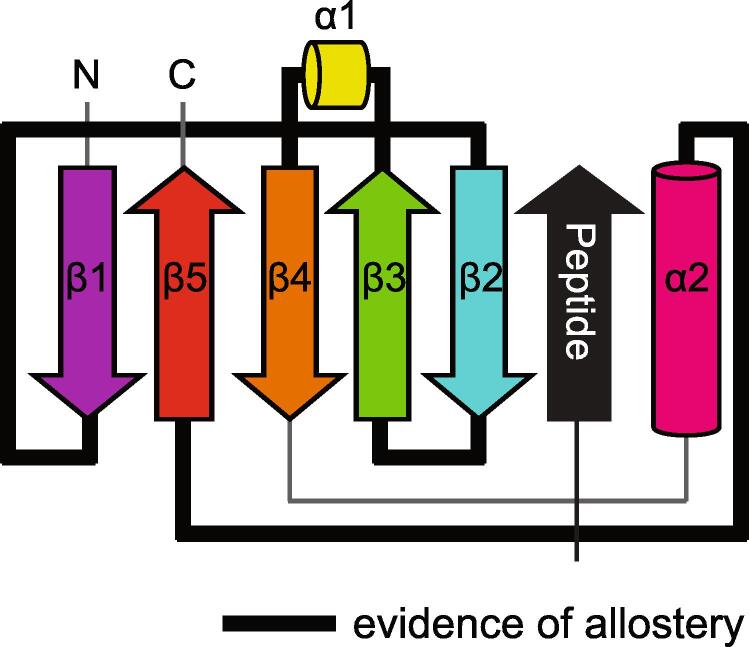
Reported regions of allostery in a PDZ domain. A two-dimensional schematic of the common PDZ domain fold is shown. The loops that have shown evidence of allostery are highlighted in bold. In addition, residues throughout the PDZ domain are implicated in long-range intradomain allosteric networks. This schematic was first published in (Valgardson et al., 2019).